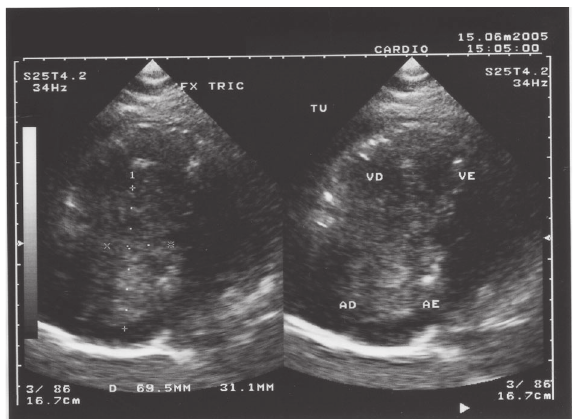
Fig. 1 - Ecocardiograma transtorácico mostrando uma massa medindo aproximadamente 2,5 x 5,5 cm, inserida no átrio